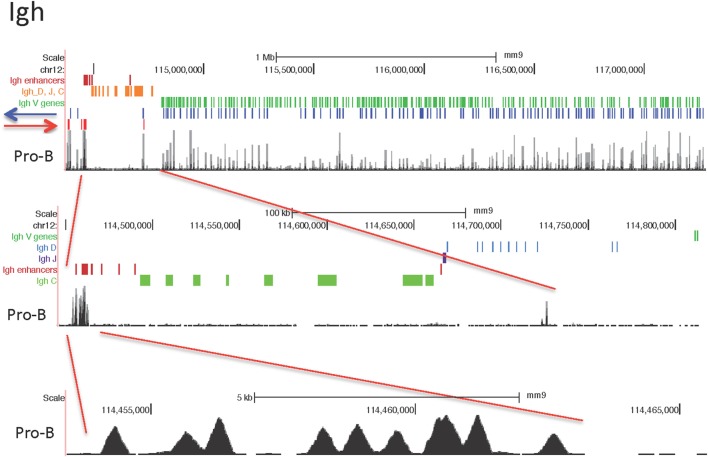
Orientation of CCCTC-binding factor (CTCF) sites in the immunoglobulin heavy chain (Igh) locus, with close-up of the D-J-C-enhancer region in the middle panel, and close-up of the 3′ regulatory region in the bottom panel.